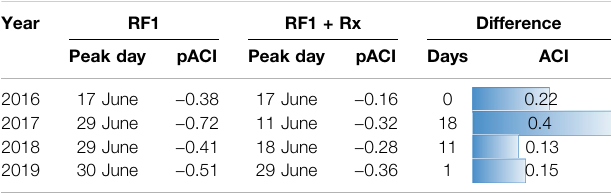
TABLE3| SummaryofpeakdayandpredictedACI(pACI)inJuneacrossallyears of monitoring at sites burned by the Rough